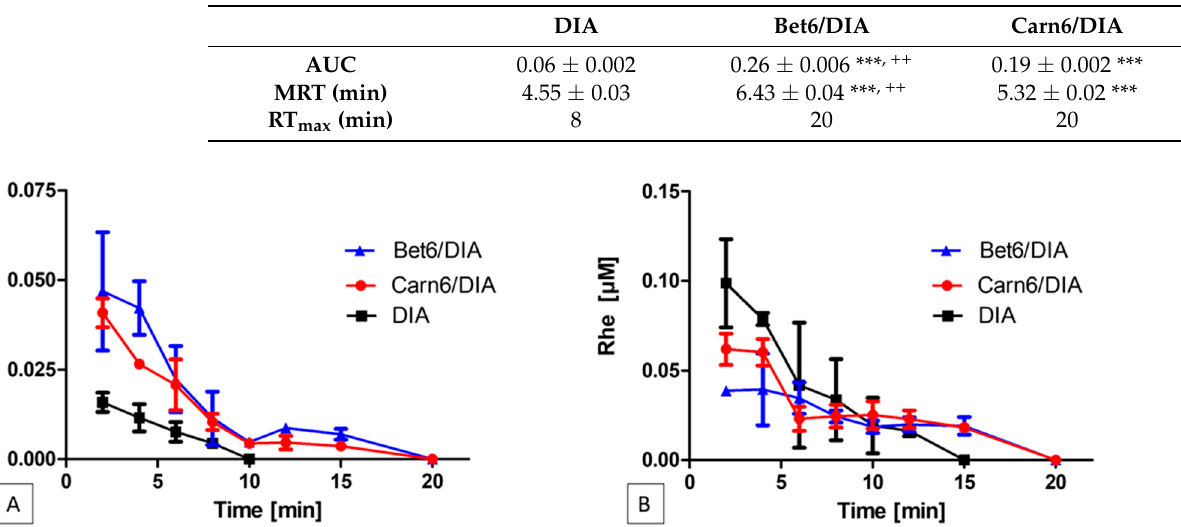
Table 3. Effects of ILs on DIA residence time in the tear fluid of rabbits after instillation of one ophthalmic drop (50 µ L) containing 0.34 M DIA and 0.27 M concentrations of different ILs. MRT, mean residence time; RT max , maximum residence time at measurable concentrations ( ≥ 2.5 µ g/mL)